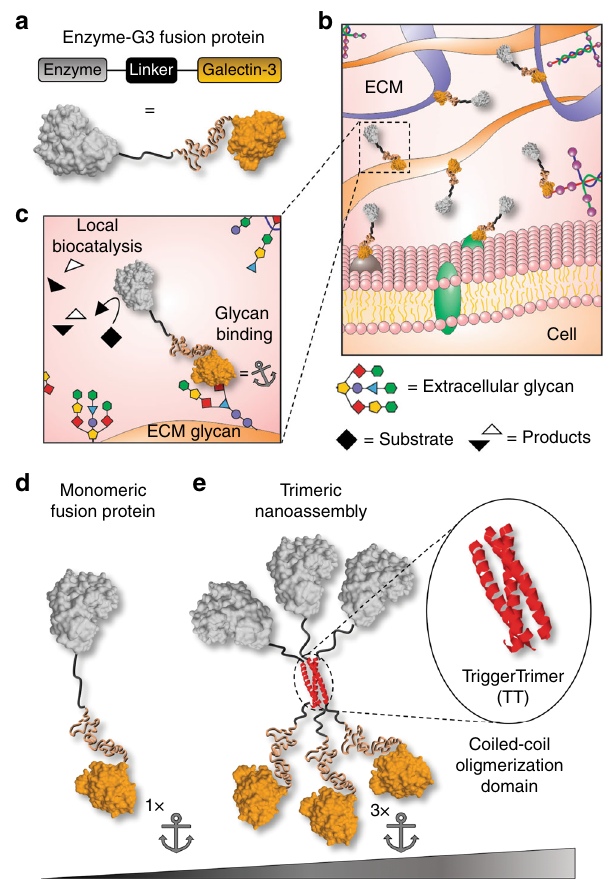
Fig. 1 Design of G3 fusion proteins to locally anchor enzymes to tissues via extracellular glycan binding. a – c Schematic of recombinant enzymes fused with galectin-3 (i.e., enzyme-G3 fusion protein), which are anchored to an injection site via binding to cell surface and extracellular matrix (ECM) glycans. d Monomeric fusion protein consisting of an enzyme linked to the N-terminal domain of galectin-3 via a fl exible peptide linker. e Trimeric nanoassembly formed by inserting the TT domain between the enzyme and G3 domains. The trimeric nanoassembly has higher glycan-binding af fi nity than the monomeric fusion protein due to multivalent avidity effects. PDB ID: 253L [10.2210/pdb253L/pdb] (generic enzyme), 2O7H